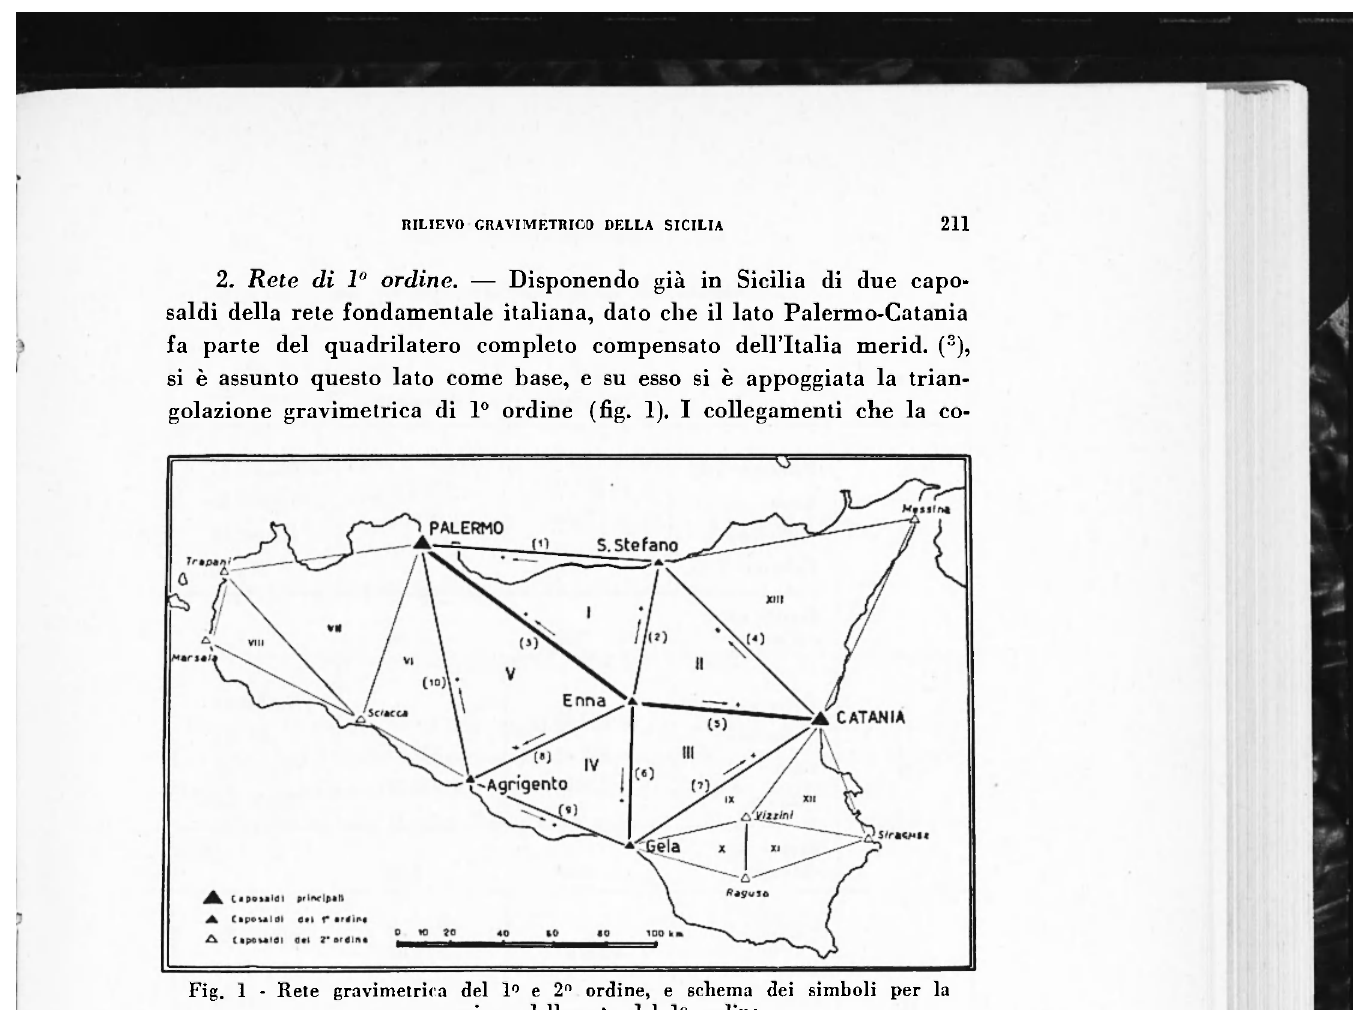
Fig. 1 - Rete gravimetrica del 1° e 2" ordine, e schema dei simboli per la compensazione della rete del 1° ordine stituiscono sono stati tutti eseguiti almeno due volte, ed i risultati os- servati e compensati sono riportati nella Tabella I. La compensazione del pentagono con un punto centrale formato dalla rete del 1° ordine è stata eseguita col metodo dei minimi qua- drati, secondo quanto andiamo ora ad